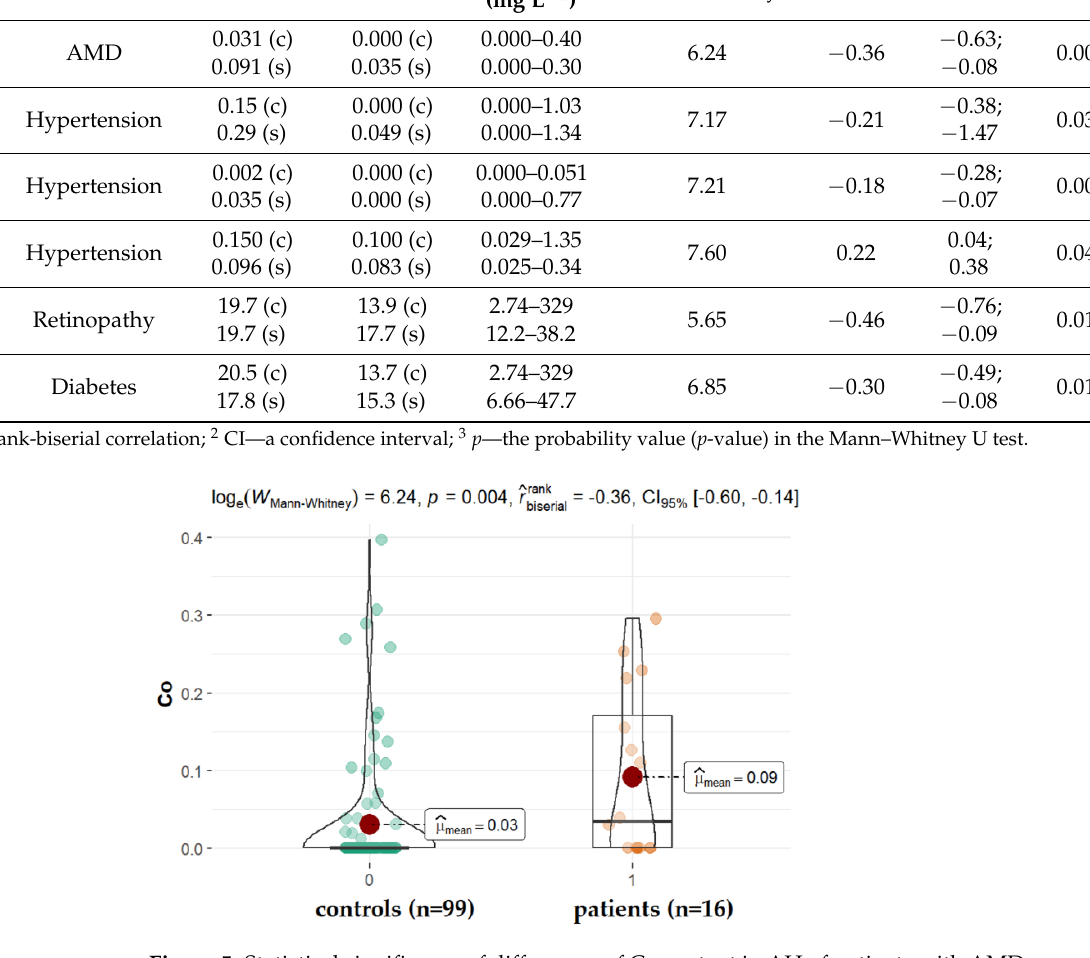
Figure 5. Statistical significance of differences of Co content in AH of patients with AMD compared to control.